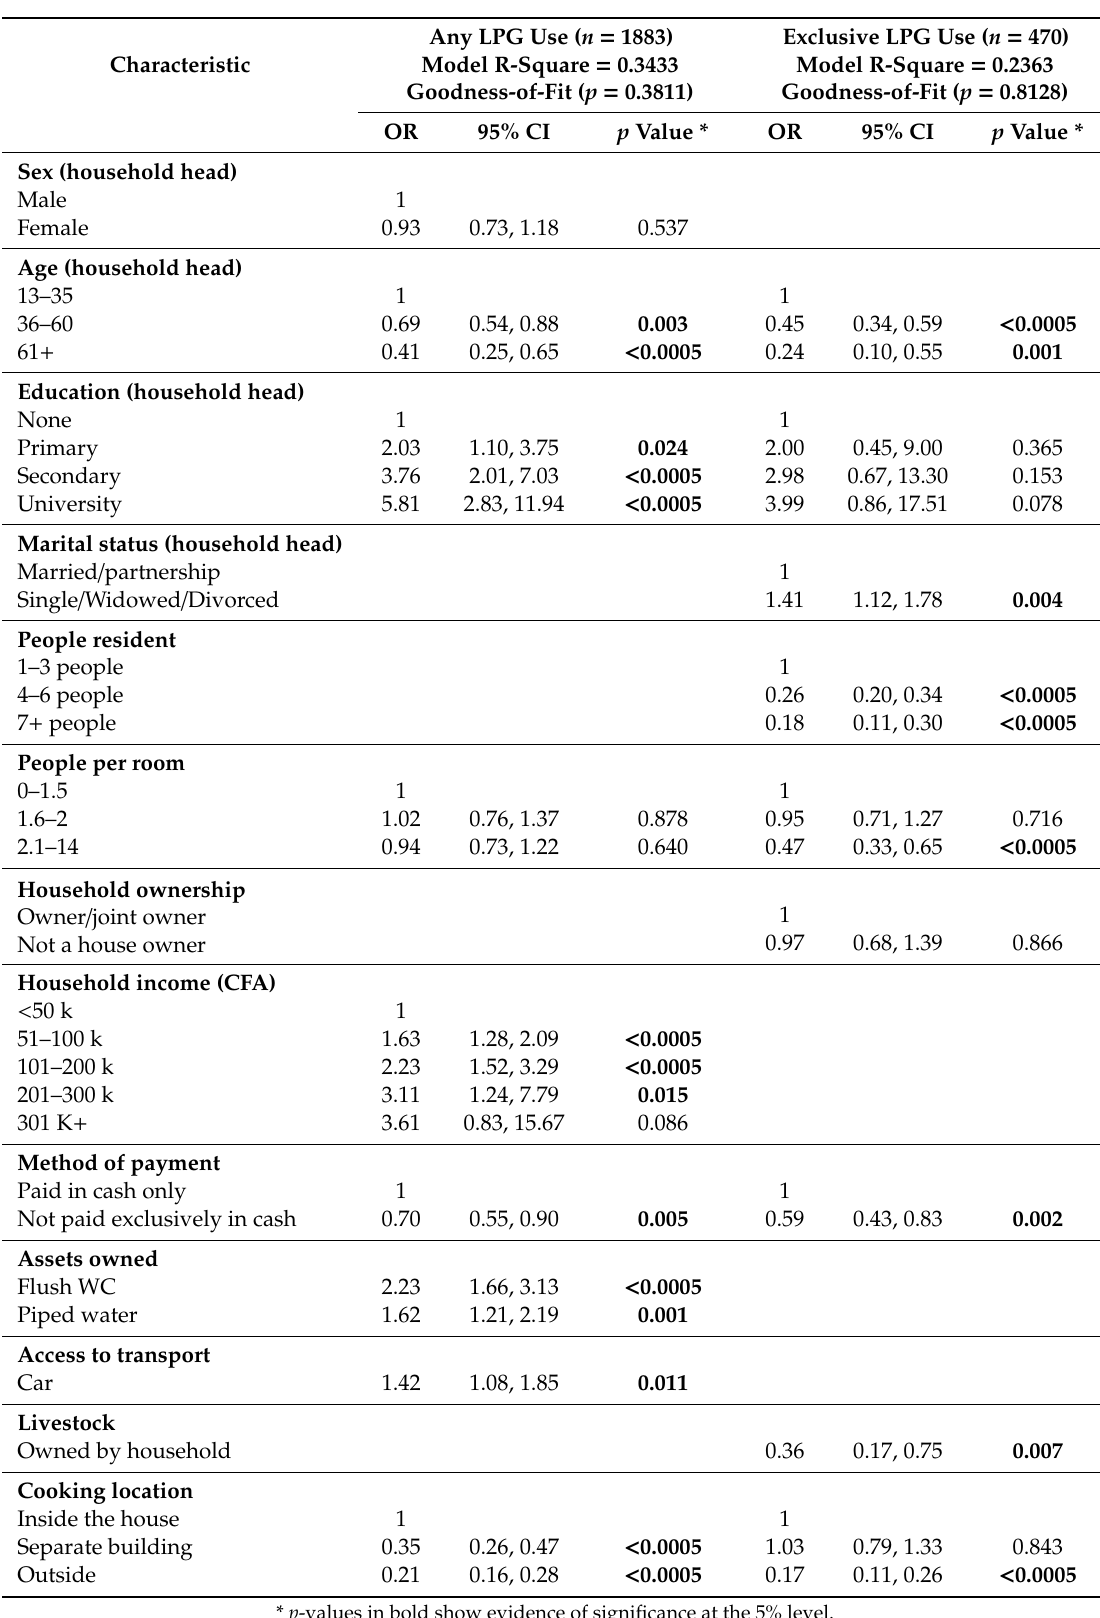
Table 9. Socio-demographic factors associated with any and exclusive LPG use in peri-urban households (using two multivariable logistic regression